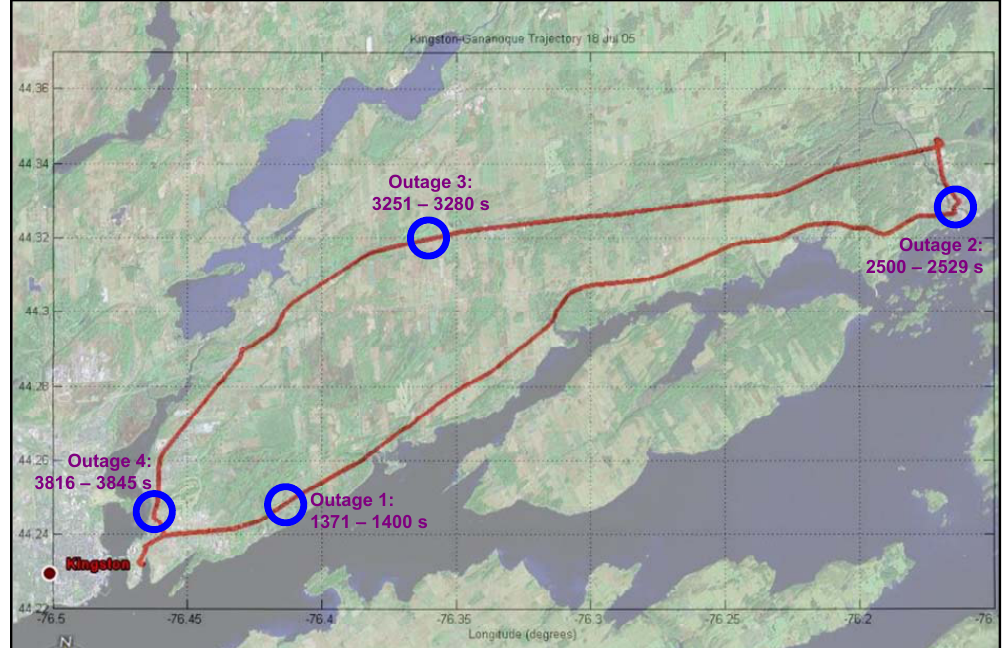
Figure 6. The first road test trajectory (for the TG6000 IMU) with the location of some intentionally introduced GPS outages